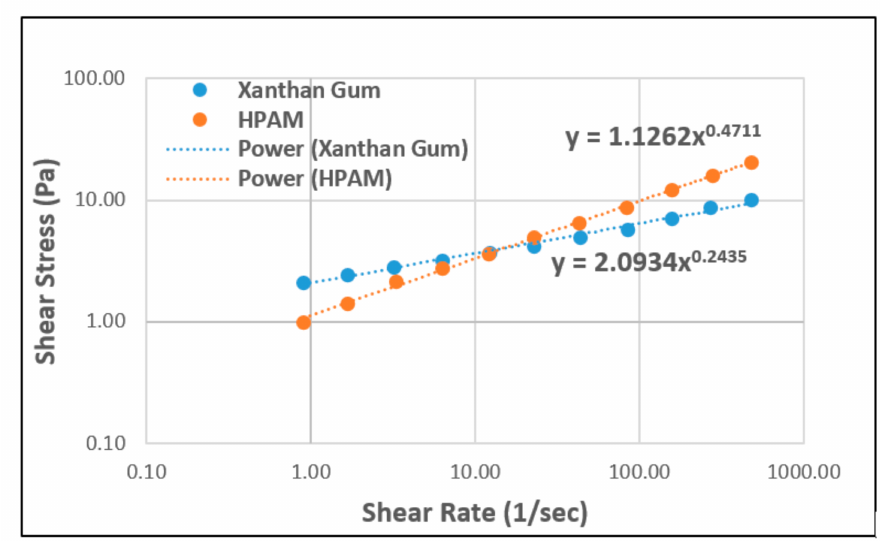
Figure 10. The shear rate vs. shear stress of HPAM and XG. Reprinted and modified from [57].